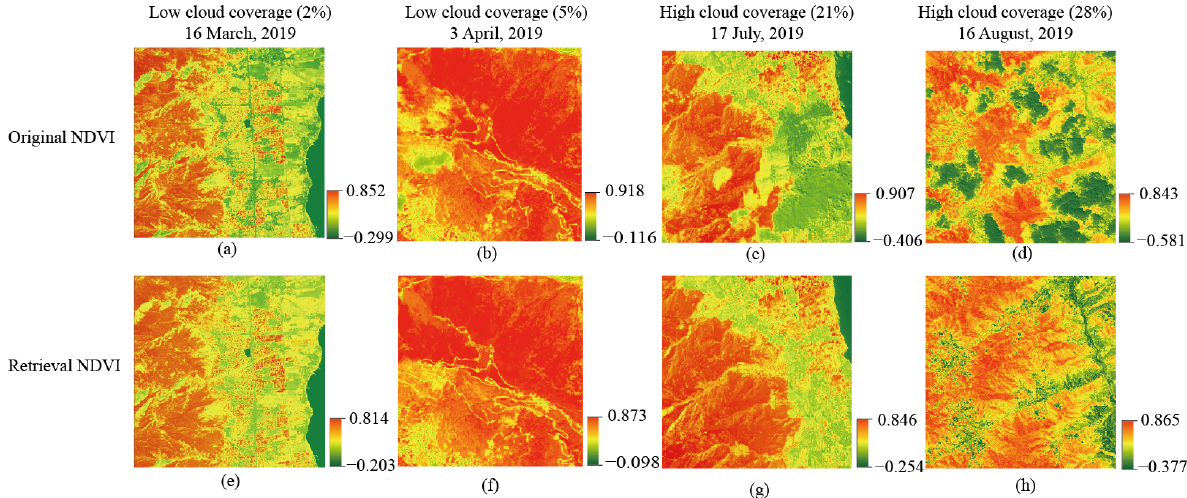
Figure 7. NDVI retrieval results of the double-attention RNN under various cloud coverage condi- tions; ( a – d ) are original NDVI images with low and high cloud coverage conditions, respectively. ( e – h ) show the retrieval results under two cloud coverage conditions of the double-attention RNN. The figures are colorized with diverging colormaps; the intermediate value is depicted in yellow, and the high value and low value are shown in red and green.